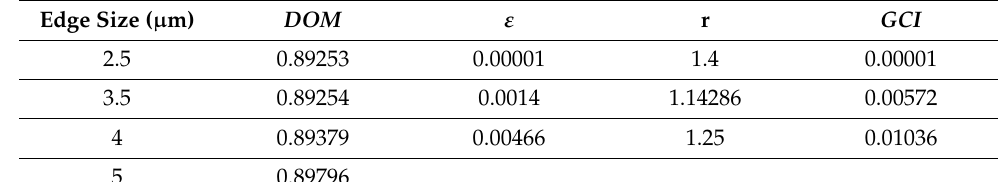
Table 1. Results of the GCI